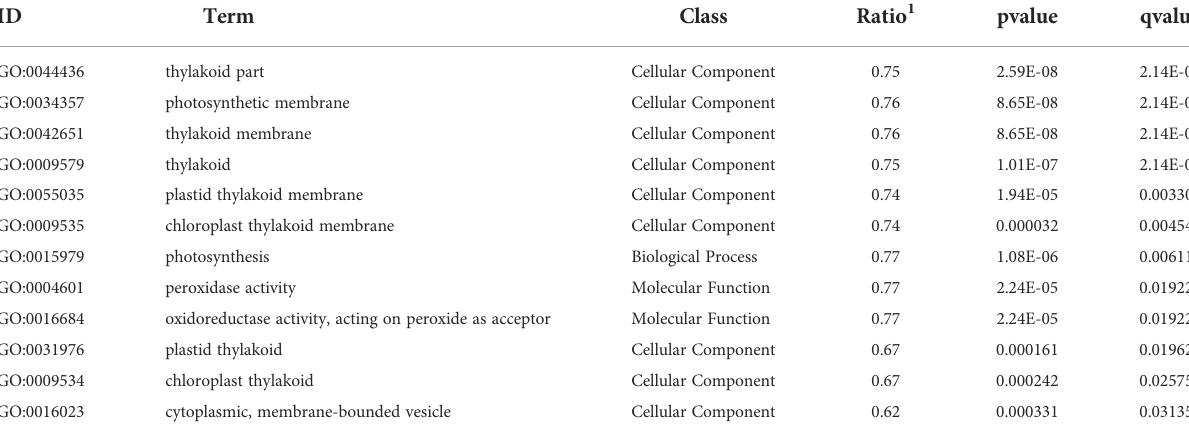
TABLE 2 Gene Ontology (GO) signi fi cantly enriched terms for differentially expressed genes (DEGs) of EC vs